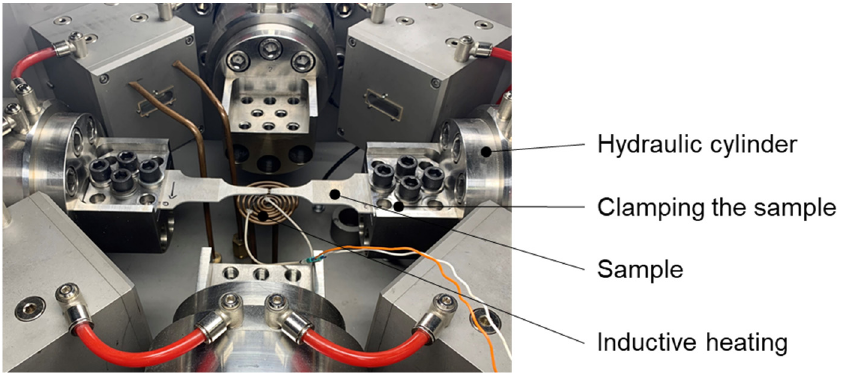
Figure 1. Biaxial testing device BTA-840 (BÄHR Thermoanalyse GmbH) at the Institute of Metal Forming, TU Bergakademie Freiberg.